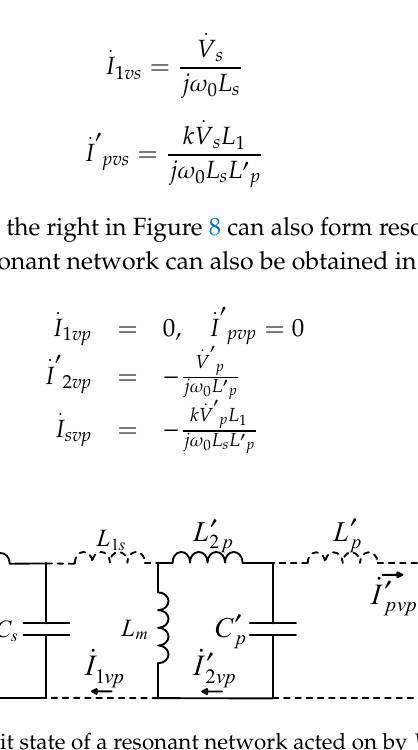
Figure 8. Circuit state of a resonant network acted on by